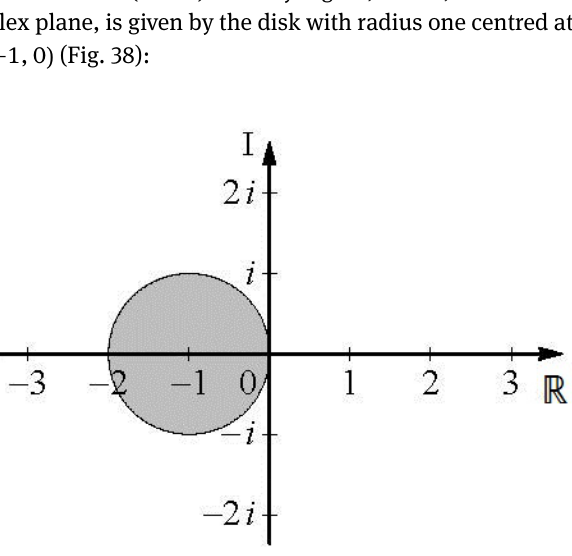
Figure 38: The gray disk shows the stability region for the Euler